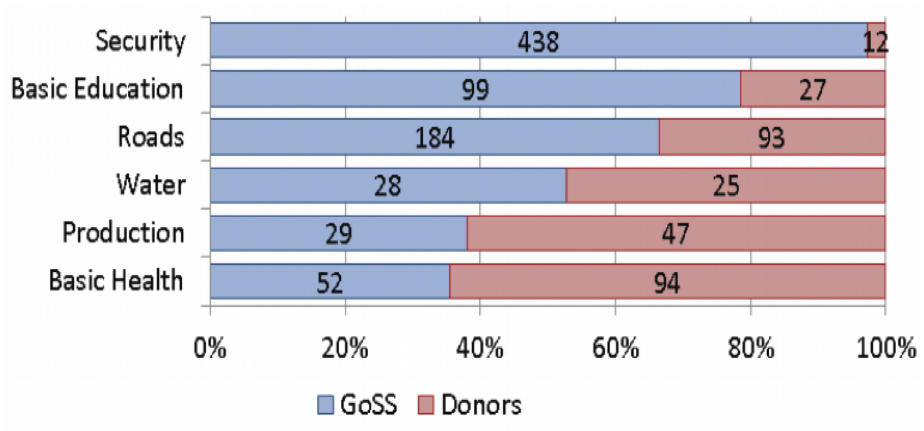
Figure 1. Funding priorities of the RSS (GoSS) versus funding priorities of international peacebuilders. Source: ([51] p.